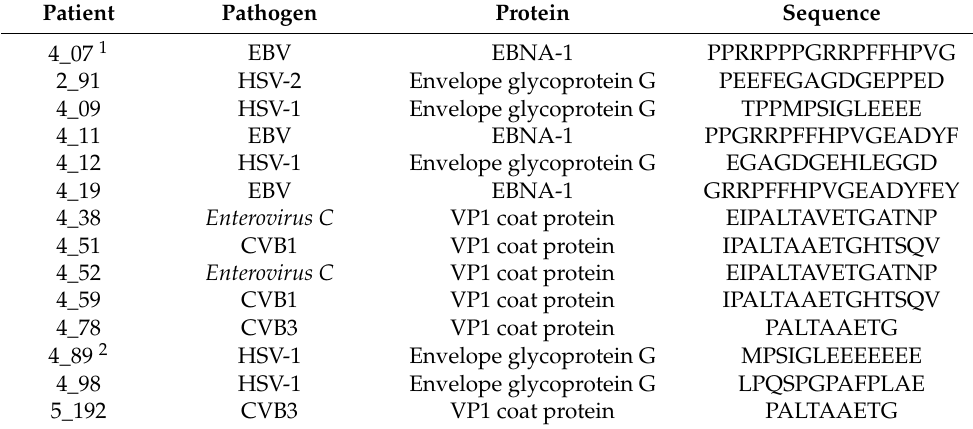
Table 1. PEPperCHIP ® Infectious Epitope MicroArray Results of monoclonal gammopathy